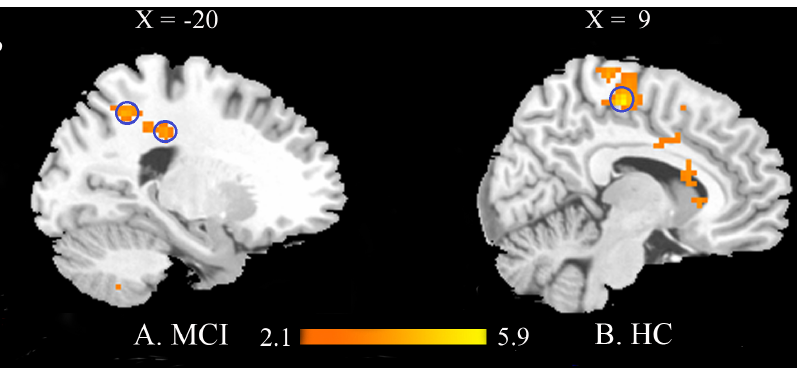
Figure 6. Brain areas with significant different ReHo values following acupuncture compared with the resting state in MCI (A) and HC (B) groups. Warm colors indicate the significantly increased ReHo values in the two groups following acupuncture at P , 0.01 (Alphasim corrected, p , 0.01, 30 voxels). (Abbreviation: MFG- Medial Frontal Gyrus).